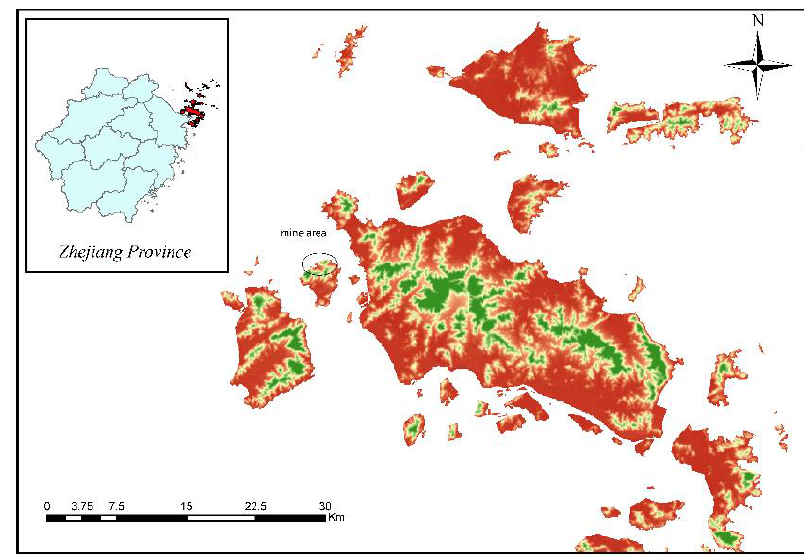
Figure 1. Geographical location of the mining area.